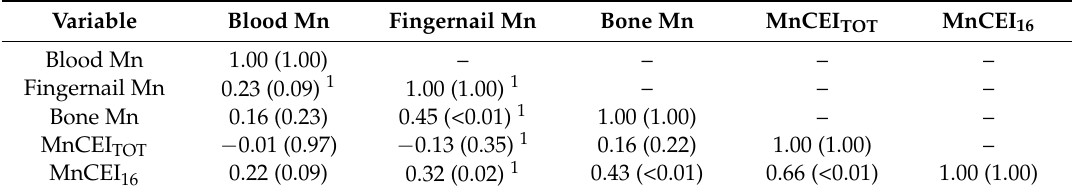
Table 2. The Spearman’s ρ ( p -value) for correlations among manganese biomarkers and cumulative exposure indices, N = 60.